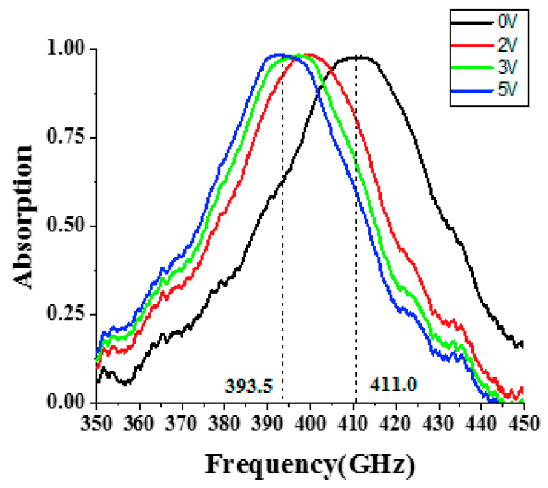
Figure 5. Measured absorption spectra of the S200 LC-based MA.